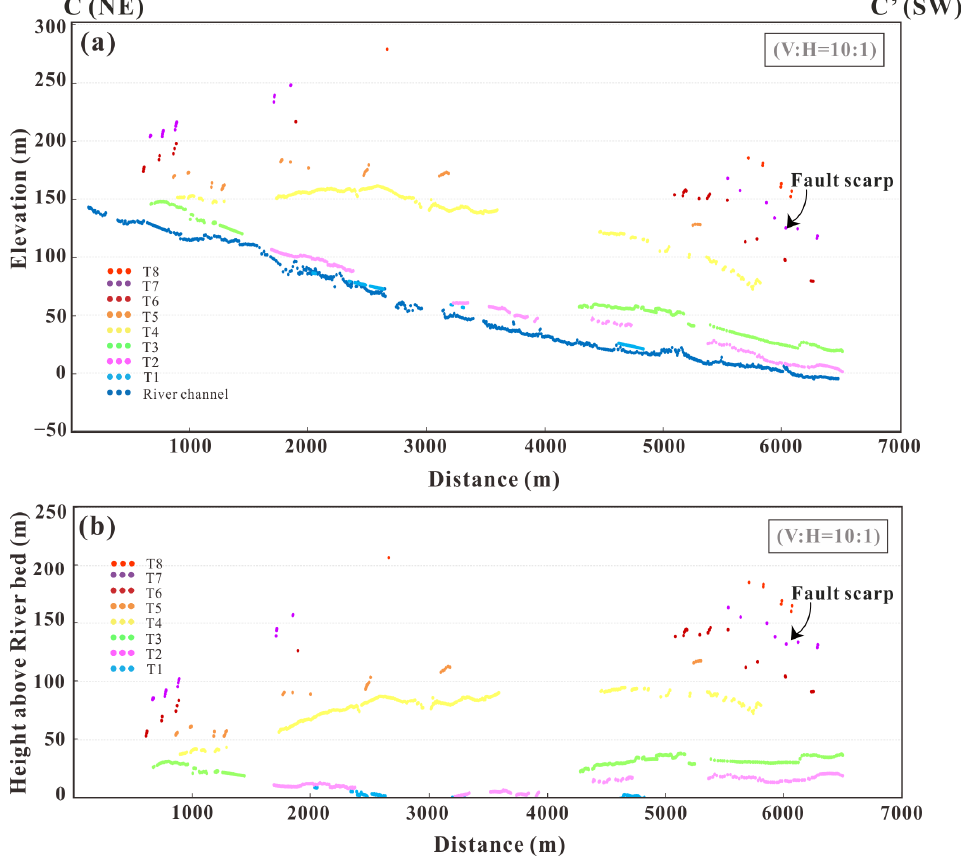
Figure 7. ( a ) Longitudinal profiles of terraces T1–T8 and river channel across the Shengjingou Valley. ( b ) Topographic profiles of terraces T1–T8 that removed the modern river gradient. The distance is projected along the line C–C (cid:48) (location see Figure 5c), where C is the direction upstream. In both profiles, the vertical exaggeration is